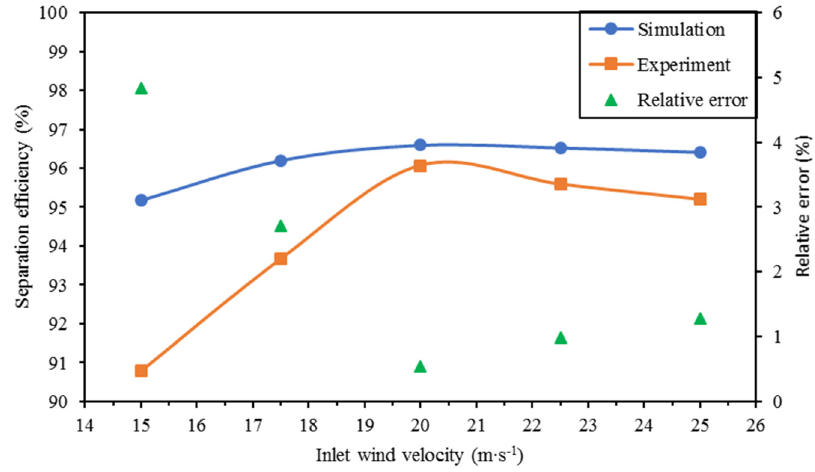
Figure 7. Separation efficiency of dust suppression device with different wind velocity.